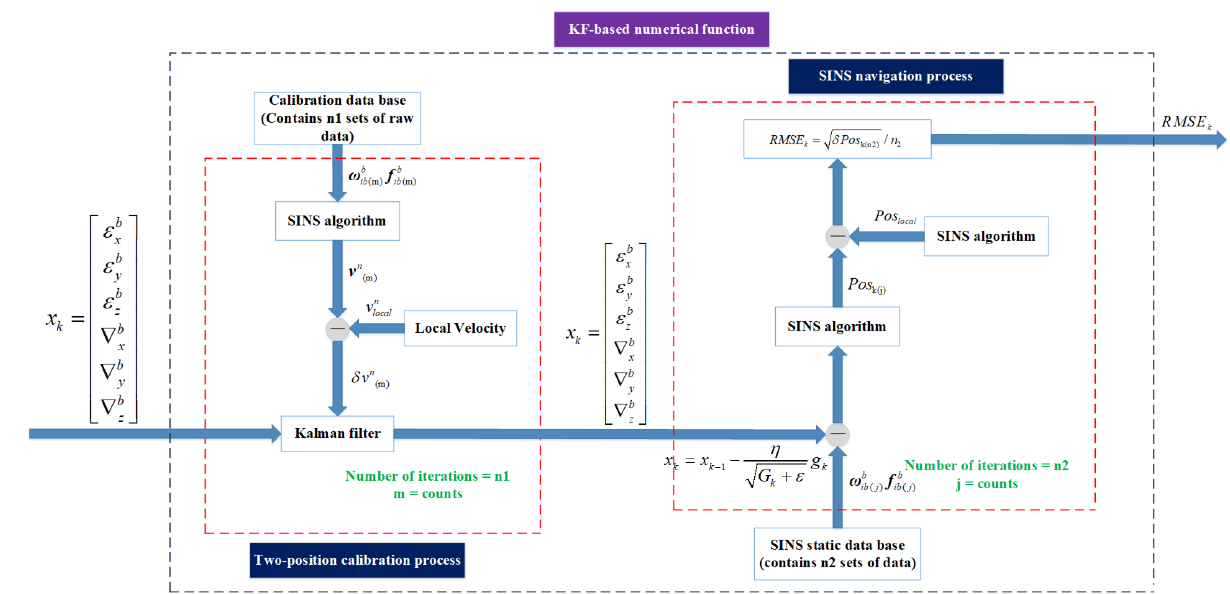
Figure 2. KF-based numerical function diagram.